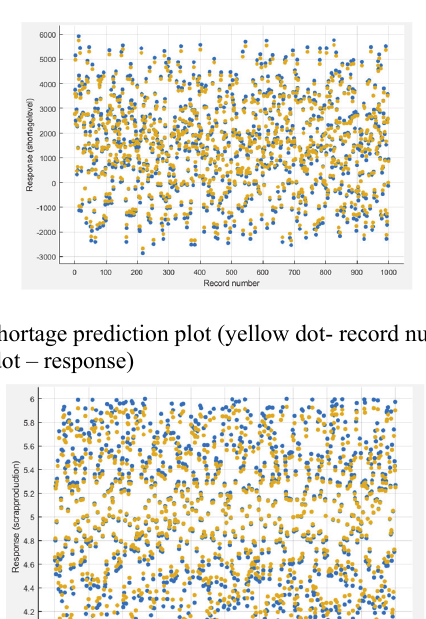
Fig. 12. Graphical comparisons of algorithms (WIP inventory model)